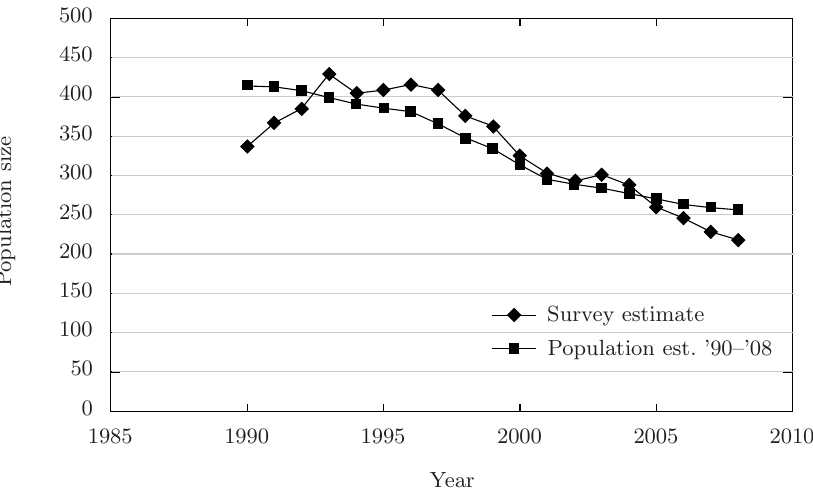
Figure 5: Black rhino surveys and population size estimates from